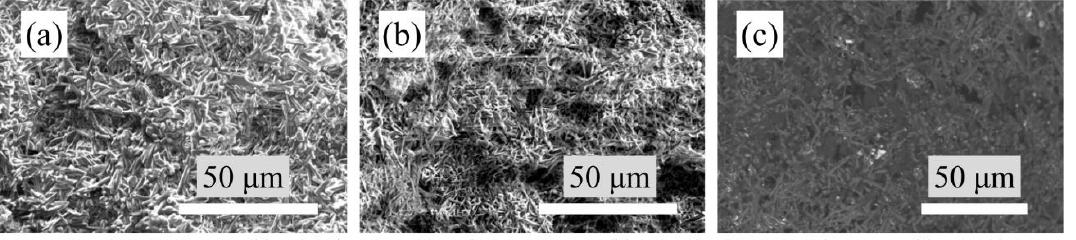
Figure 4. SEM micrographs of the microstructure of sintered samples: ( a ) undoped samples, ( b ) with YSZ and ( c ) with MSZ.